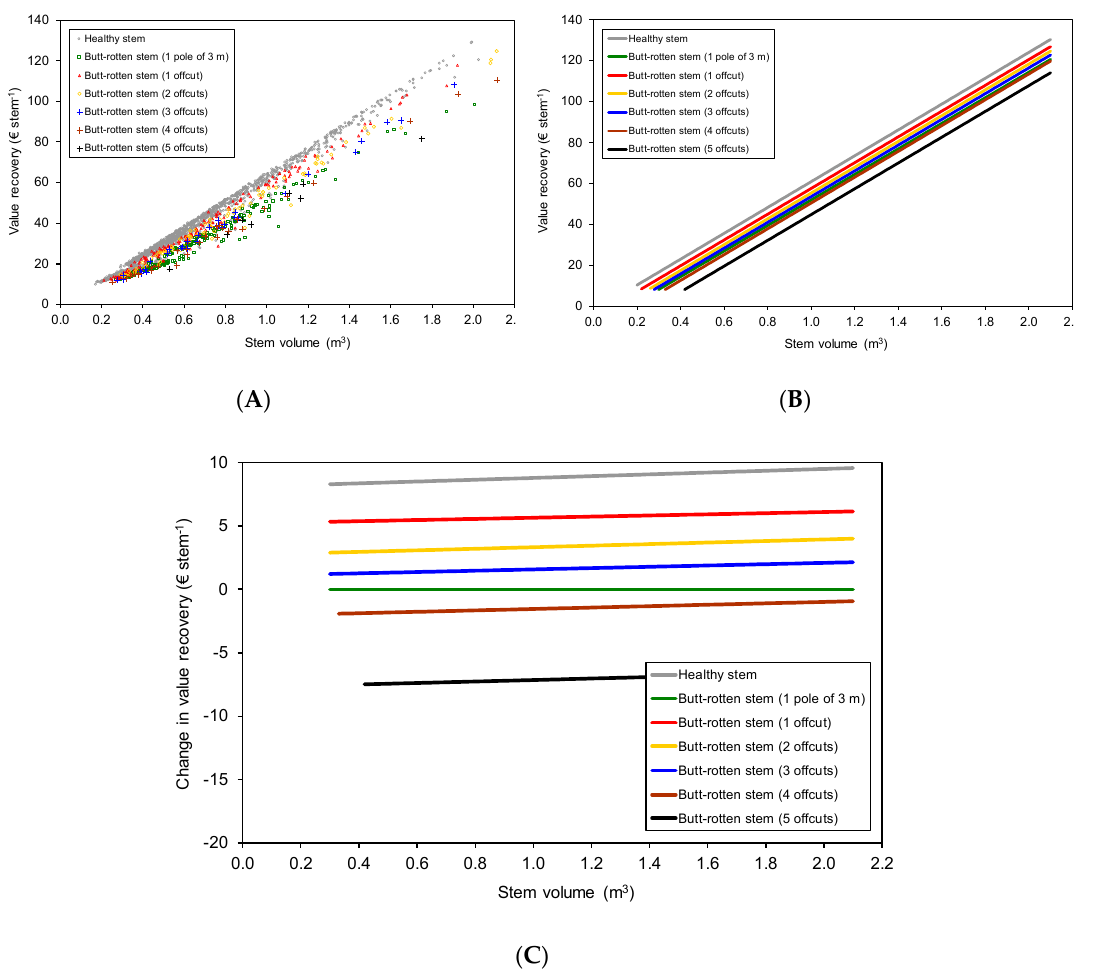
Figure 6. Observations of the value recovery of the stem at the roadside landing ( A ), calculated value recovery lines ( B ) (Table 7), and change in the value recoveries by cross-cutting practice ( C ) compared to cross-cutting practice two (Zero level = cutting of one pole of 3 m) as a function of the stem volume. 3.5. Modelling Relationship between Diameter and Height of Decayed Column in Butt-Rotten Stems Table 7. Regression models for the value recovery of the stem at the roadside landing by cross-cutting practice. The mean diameter of the stems measured at the stump height was 33.5 cm (std: 8.8 cm),